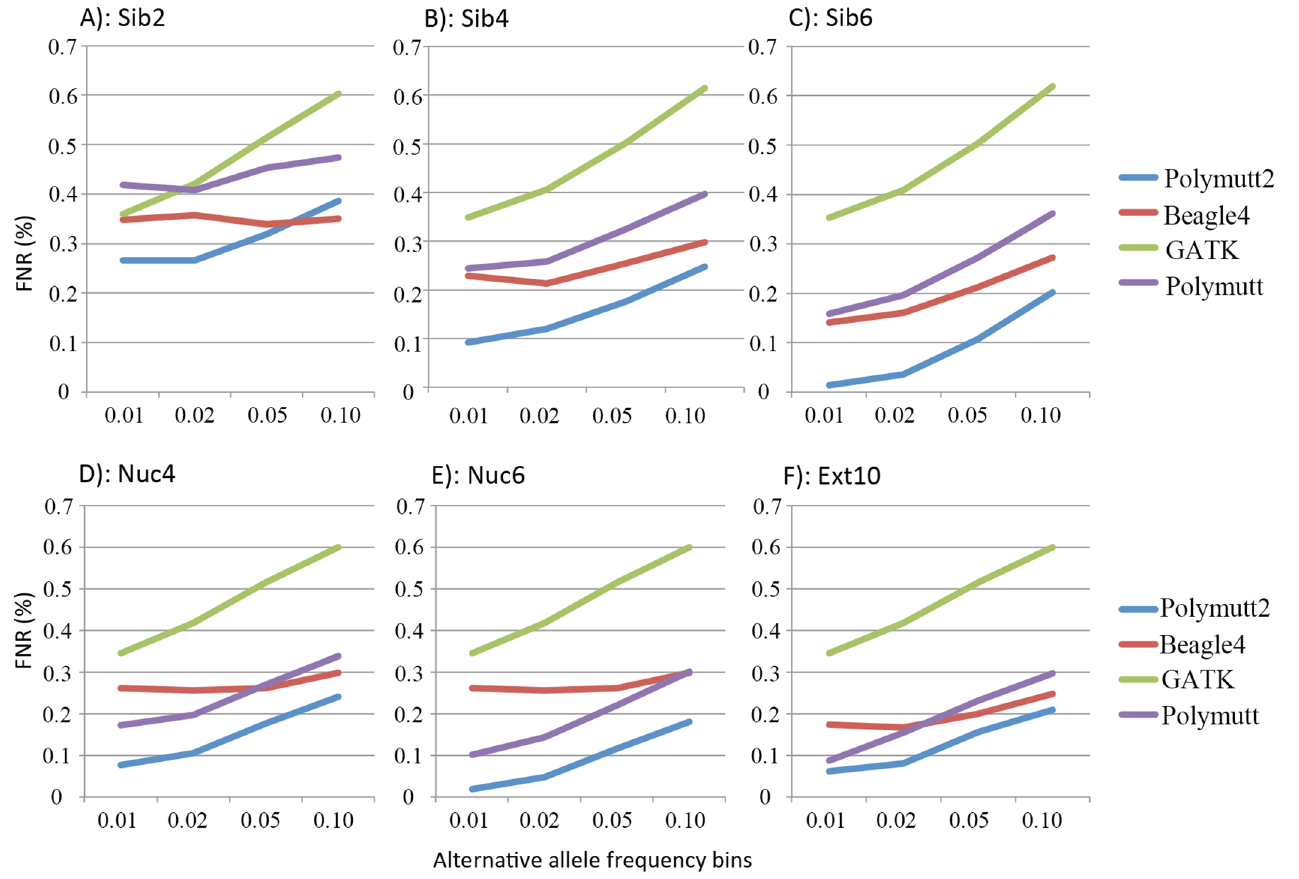
Fig 3. The FNR (%) of the heterozygotes in 6 pedigrees from four callers (Polymutt2, Beagle4, GATK and Polymutt) for variants with alternative allele frequencies in 4 bins in the range of [0, 0.1] at sequencing coverage of 20X. Results of different pedigrees are shown in panel A) for Sib2, B) for Sib4, C) for Sib6, D) for Nuc4, E) for Nuc6 and F) for Ext10.